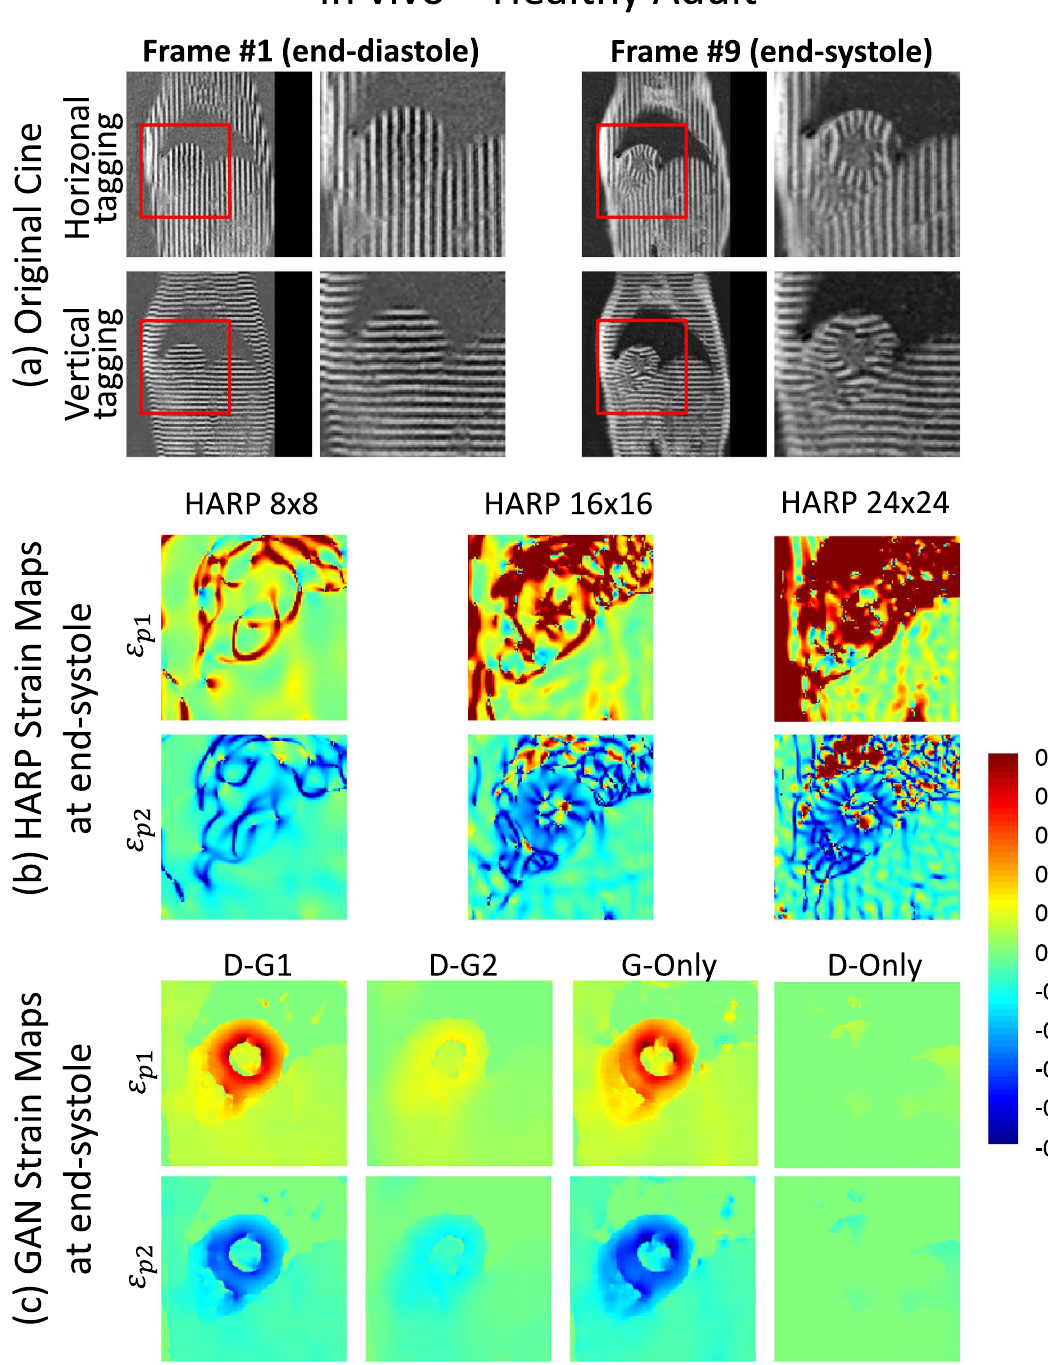
Figure 3. In-vivo principal strain maps at end-systole and end-diastole. Principal strain maps were calculated of the MR tagging dataset of a healthy adult using HARP and directly mapped using the proposed GAN architecture methods. Raw line tagging images of the end-diastole and end-systole time frames are shown in ( a ). HARP technique strain maps are displayed in ( b ) using various parameters. Finally, the resulting strain maps from our proposed GAN techniques are demonstrated in ( c